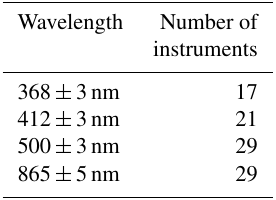
Table 2. Number of instruments submitting AOD data for each wavelength during